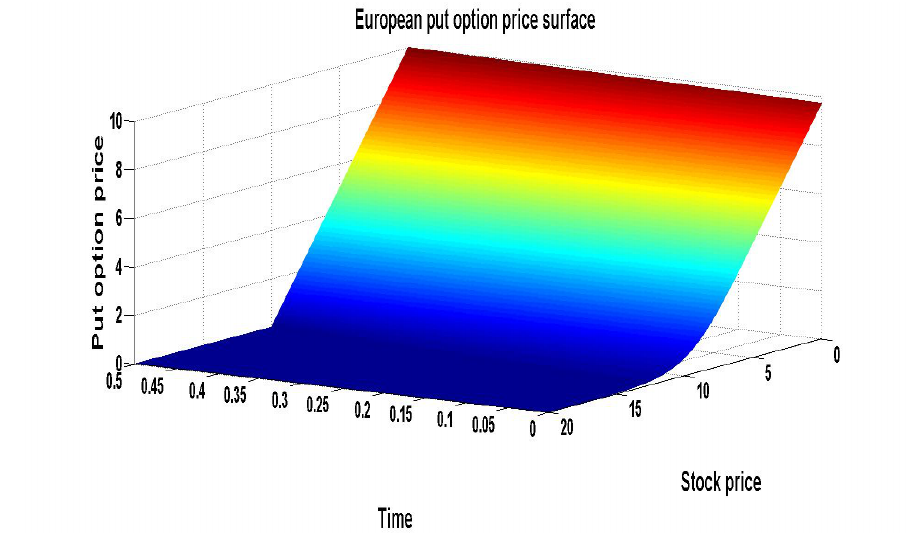
Figure 7. Collateralized European put option surface using the PDE approach with ∈ [0 , 20] , K = 10 , dt = 0 . 0001 (5000 time increments), ds = 0 . 02 parameters: S 0 (1000 space increments), T = 0 . 5 , t ∈ [0 , T ] , r σ = 0 . 3 and θ = 1